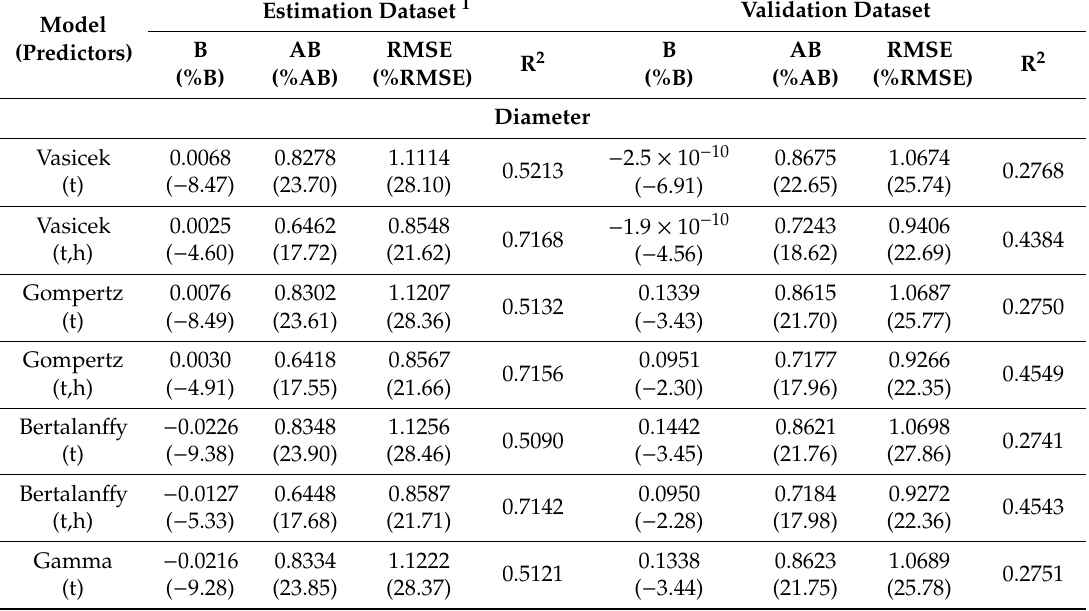
Table 8. Statistical measures for all fitted mixed-e ff ect parameter diameter, D, and height, H,